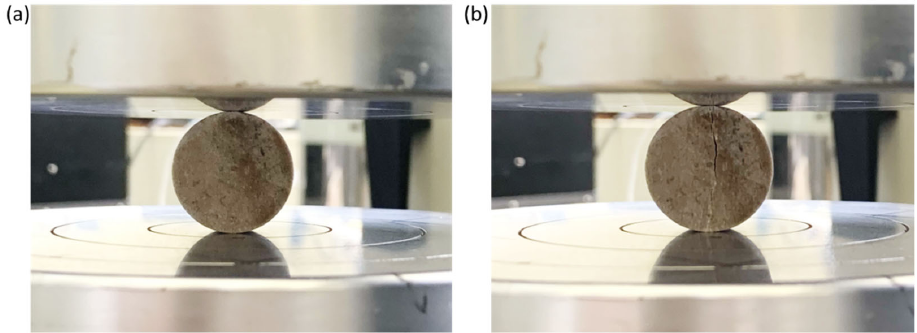
Figure 9. Photographs depicting rock sample 2/5/2 between loading plates: ( a ) before loading; ( b ) after loading.